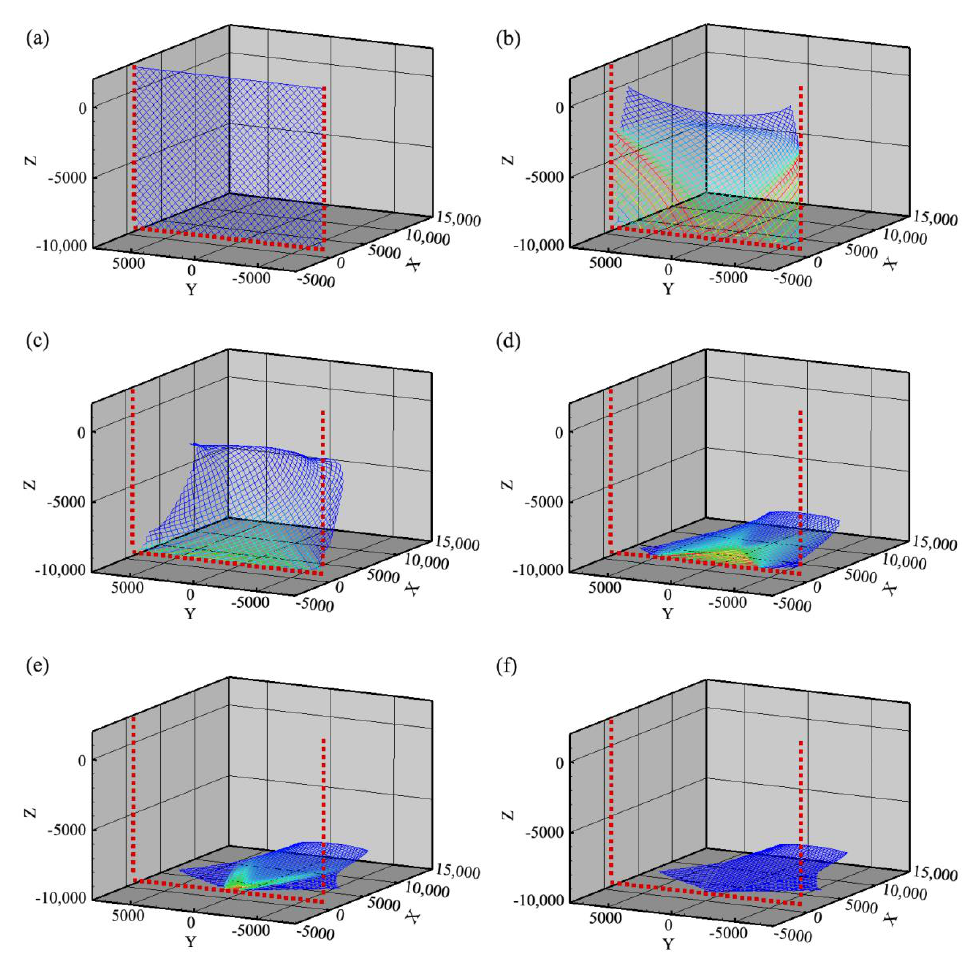
Figure 16. Damage process of mooring system for the trash-blocking nets when T m = 4.0